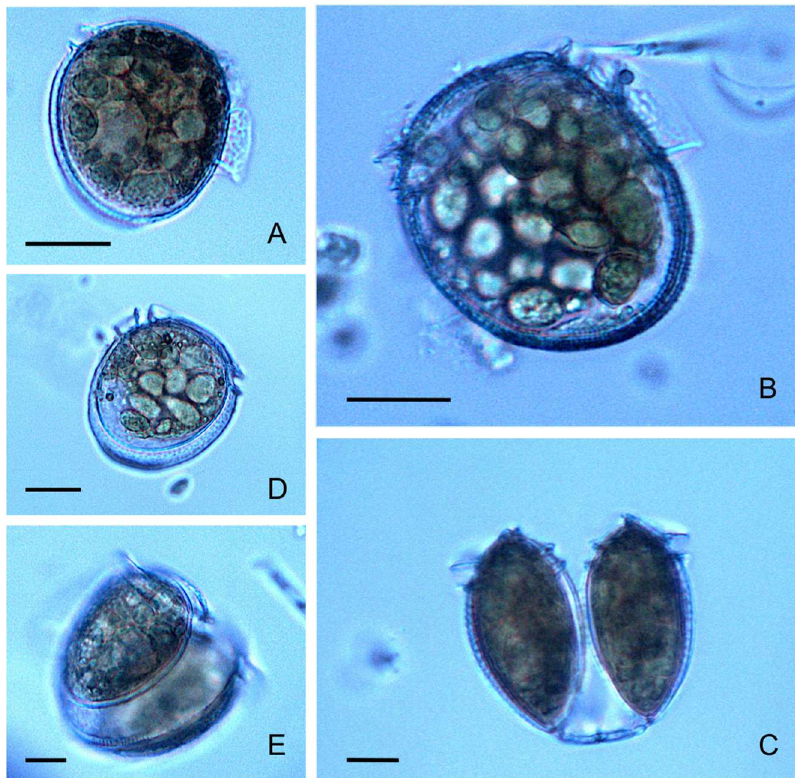
Figure 4. Phalacroma rotundatum micrographs showing different cell cycle (vegetative) phases and life cycle stages. ( A , B ) Fully developed single cells showing abundant digestive vacuoles; ( C ) recently divided vegetative paired cells showing the megacytic bridge; ( D ) recently divided intermediate-sized cell of P. rotundatum, with digestive vacuoles and incomplete development of the left sulcal list; ( E ) dimorphic paired cells undergoing depauperating division; scale bar = 20 µ m applies to all frames.